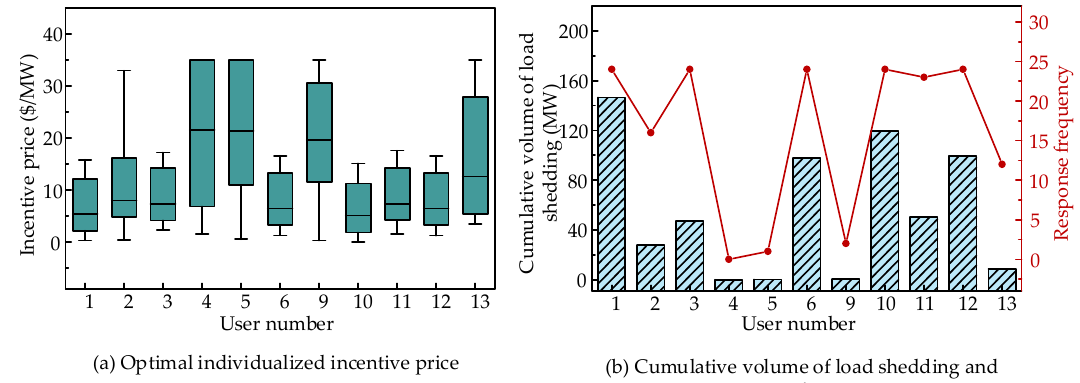
Figure 4. Equilibrium results of optimal individualized incentive price ( a ) as well as cumulative volume of load shedding and response frequency ( b ) when the proposed dual-incentive mechanism is adopted.